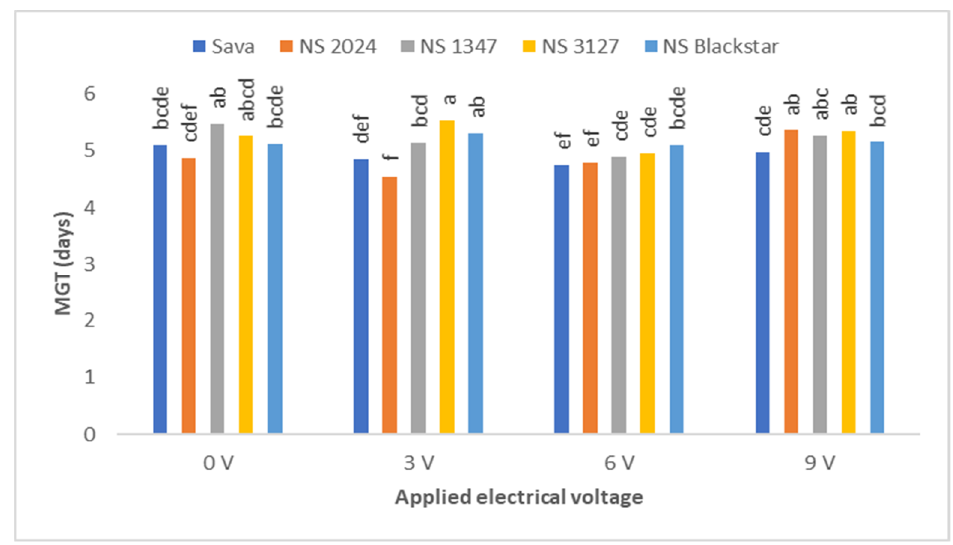
Figure 4. Effect of the interaction of soybean genotypes × electrostatic field on mean germination time (MGT). Different letters above the bars represent significant differences at the p ≤ 0.05.